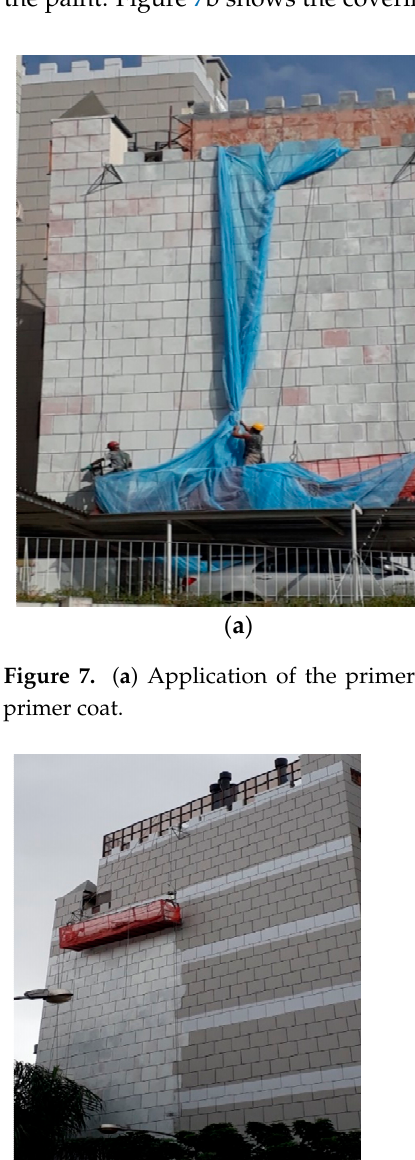
Figure 8. On the right, the finishing coat after application.